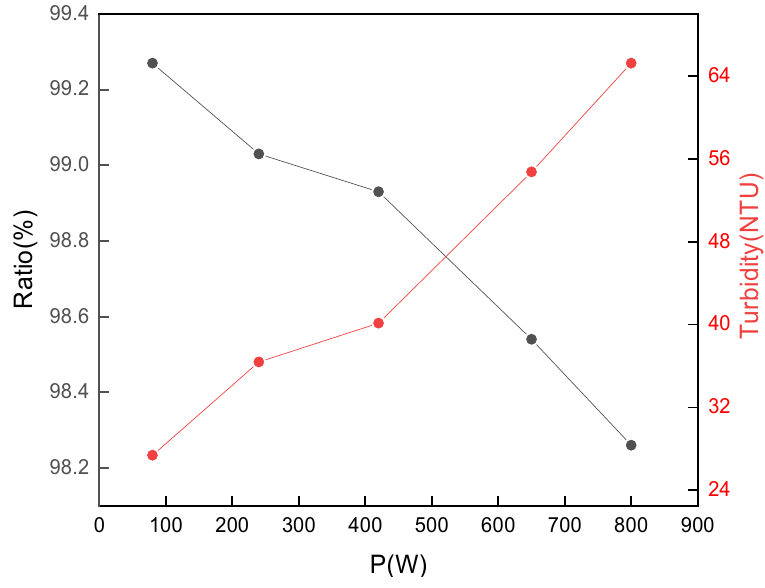
Figure 8. Effect of microwave oven power on the turbidity removal ratio.